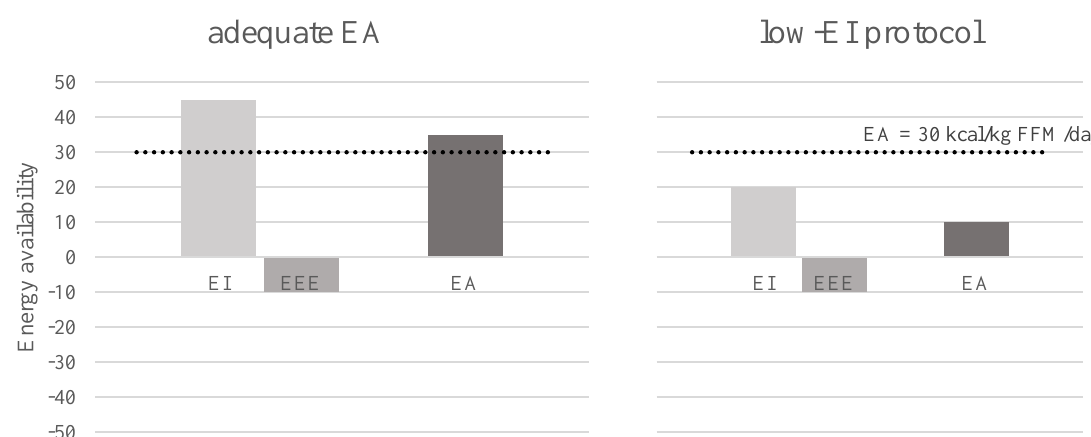
Figure 2. A schematic representation of low-EI protocol. EEE remains identical, while EI is reduced in a way to reach a target EA.